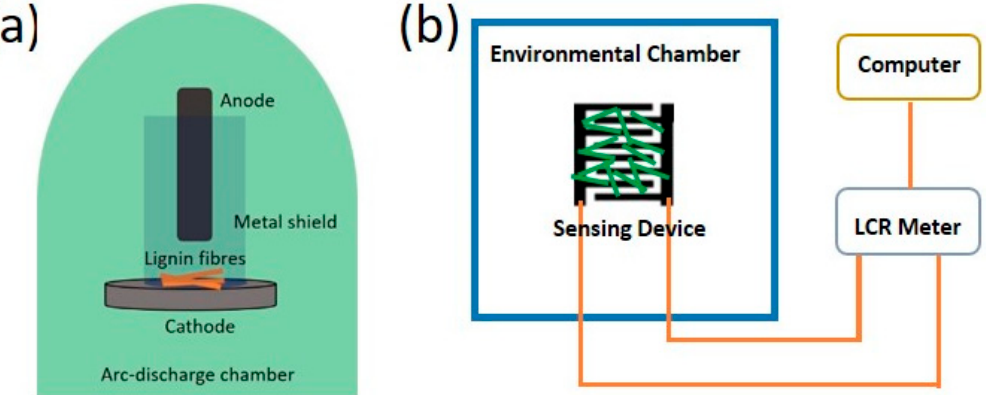
Figure 1. ( a ) Schematic diagram of the plasma arc discharge apparatus used to treat lignin fibres. ( b ) Schematic of the humidity sensor measurement setup.